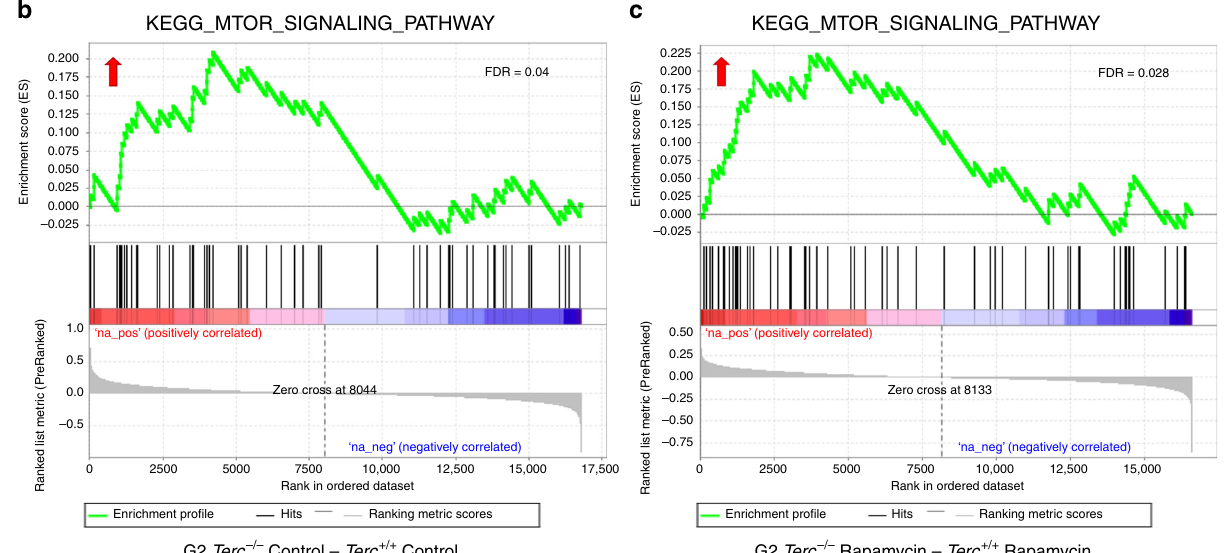
Fig. 5 Telomerase-de fi cient mice show an upregulated mTOR pathway. Gene expression data obtained by RNAseq of three independent liver samples from Terc + / + and G2 Terc − / − male mice subjected to control or rapamycin diet and sacri fi ced after 2 months of treatment were analyzed by Gene Set Enrichment Analysis (GSEA) to determine signi fi cantly enriched gene sets. a Table showing signi fi cantly enriched gene sets (FDR < 0.25) between control-fed G2 Terc − / − and Terc + / + . Note the upregulation of several metabolic pathways in telomerase de fi cient as compared to wild-type mice (for a complete list of deregulated pathways see Supplementary Table 1). The database used was the Kyoto Encyclopedia of Genes and Genomes (KEGG). b , c Gene set enrichment analysis (GSEA) plots for the mTOR pathway in G2 Terc − / − versus Terc + / + mice subjected to control ( b ) or rapamycin ( c ) diet. The red to blue horizontal bar represents the ranked list. Genes located at the central area of the bar show small differences in gene expression between the pairwise compared. At the red edge of the bar are located genes showing higher expression levels in G2 Terc − / − control fed ( b ) or G2 Terc − / − rapamycin- fed ( c ) mice; at the blue edge of the bar are located genes showing higher expression levels in Terc + / + control fed ( b ) or Terc + / + rapamycin-fed ( c ) mice. Red arrows indicated upregulation of the mTOR pathway in the pairwise comparisons. False discovery rate (FDR) is indicated in each